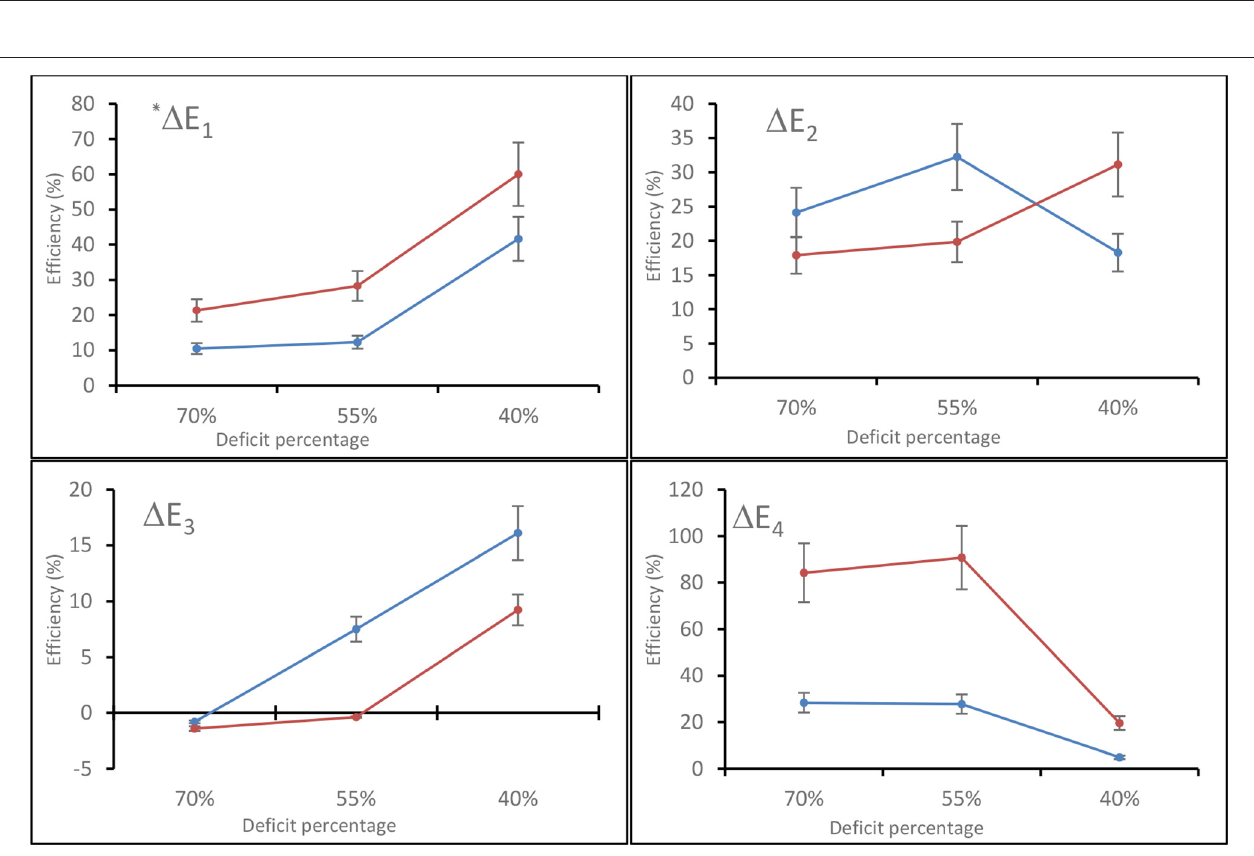
FIGURE 3 | The percentage of an improvement in the efficiency of each step in the 1st cutting season compared to FI. * 1 : Parameter from Equation (8).